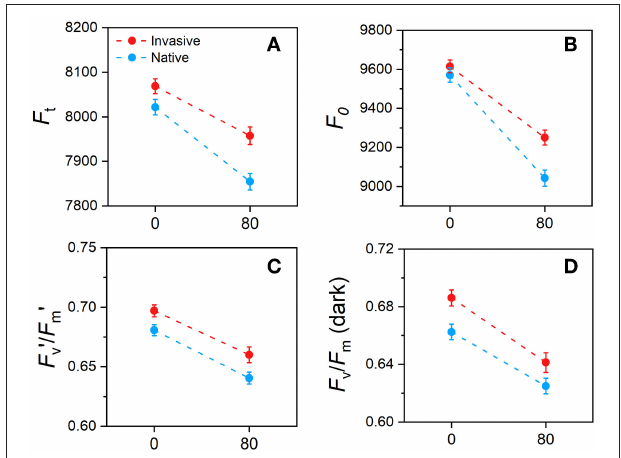
FIGURE 7 | Changes in chlorophyll fluorescence parameters in young-mature (i.e., just after reaching their final size) leaves of invasive and native plants during long term stress and acclimation in response to cadmium (Cd) treatment (A) F t , ground fluorescence in the light-adapted state (B) F 0 , ground fluorescence in the dark-adapted (C) F v ′ /F m ′ , maximum chlorophyll fluorescence in the light-adapted (D) F v /F m maximum chlorophyll fluorescence in the dark-adapted state. Values are means ± standard error (SE). Notes, 0, control 80, Cd concentration mg/kg.